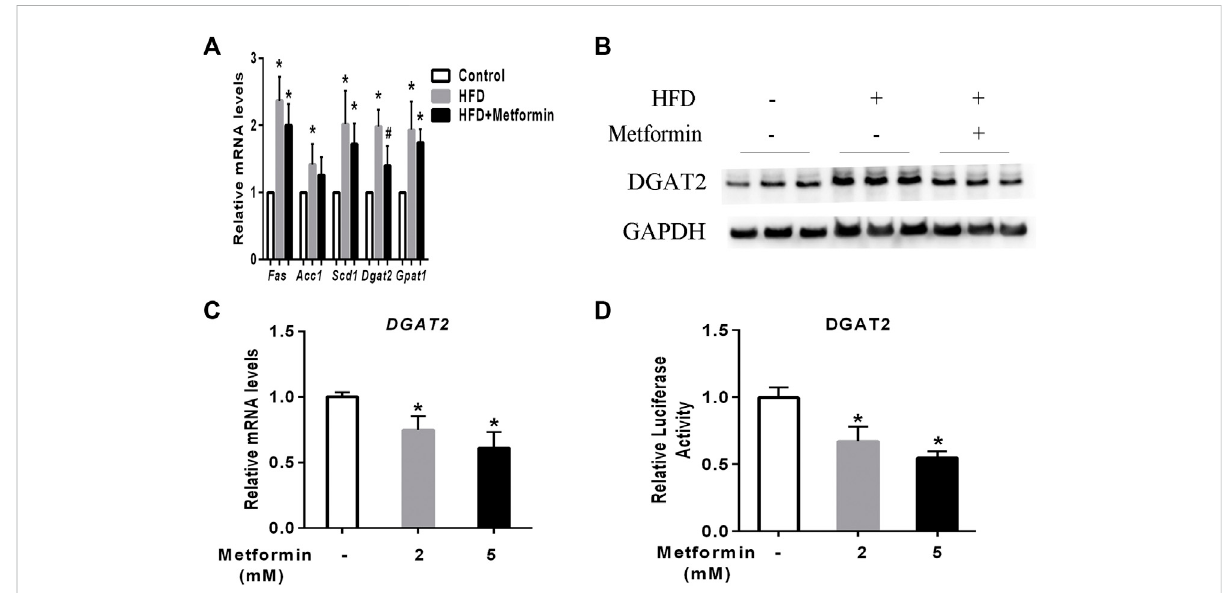
FIGURE 2 MetformindecreasedDGAT2expressionintheliverofmiceandinHepG2cells. (A) ThehepaticmRNAexpressionof lipogenicgenesand (B) DGAT2 protein in the liver of the mice fed control diet and HFD with or without metformin treatment for 5 weeks. p p < 0.05 compared with control mice. #p < 0.05 compared with HFD-fed mice, n = 6 – 8. (C) Relative levels of DGAT2 mRNA in HepG2 cells treated with 2 mmol/L or 5 mmol/L metformin for 24 h. (D) Relative luciferase activity of DGAT2 in HepG2 cells treated with 2 mmol/L or 5 mmol/L metformin for 24 h p p < 0.05 compared with control. Data are presented as the mean ± SEM of at least three independent